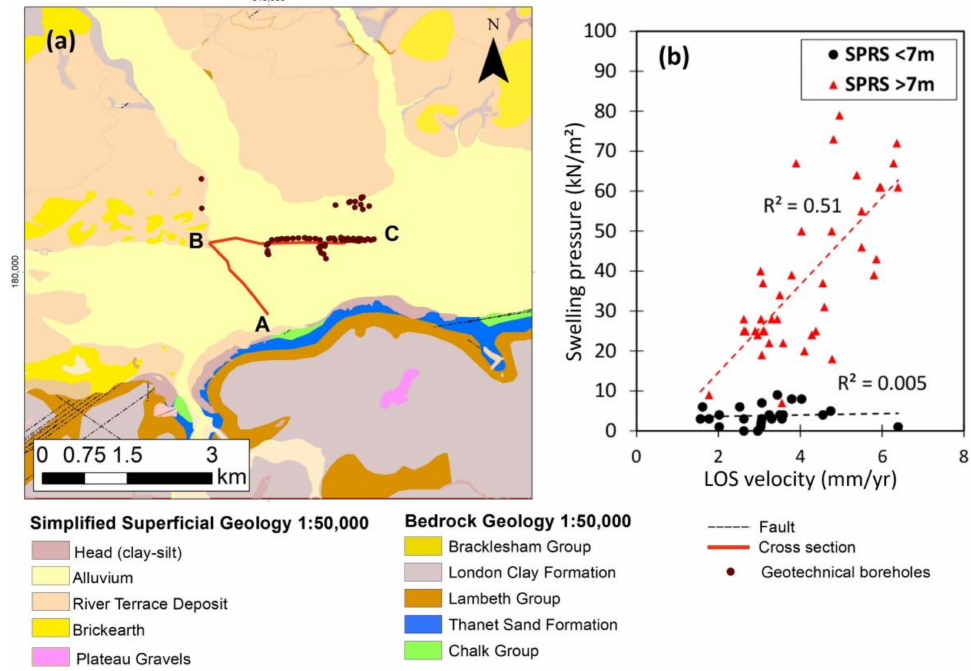
Figure 9. ( a ) Location of the geotechnical boreholes; ( b ) Comparison of the LOS velocity estimates in the period 2015–2017 with the swelling pressure of the superficial (depth lower than 7 m) and deeper layers (higher than 7 m). Simplified Superficial Geology of Greater London modified from the DiGMapGB50, the Digital Geological Map of Great Britain at the 1:50,000 scale and bedrock geology at the 1:50,000 scale, with the permission of the British Geological Survey. All rights